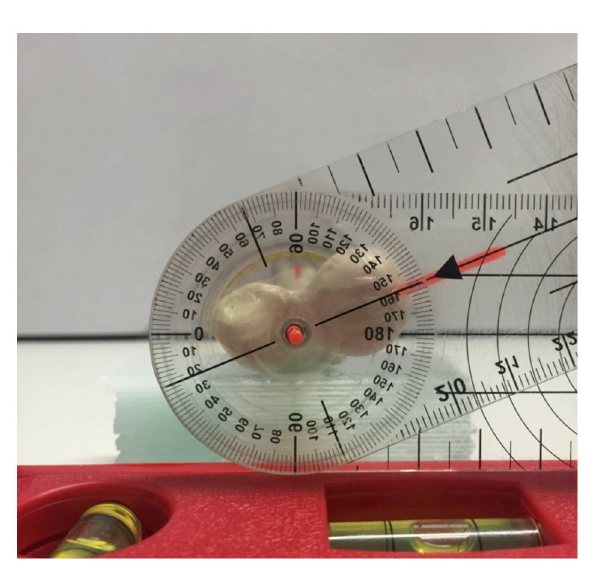
FIGURE2 Manual goniometer measurements of the femoral torsion angle. Proximodistal view on the torsional deformity model with the pivot point of the goniometer inserted into the femoral longitudinal axis rod. The legs of the goniometer are aligned with the retrocondylar axis (spirit level) and the plastic rod of the femoral neck